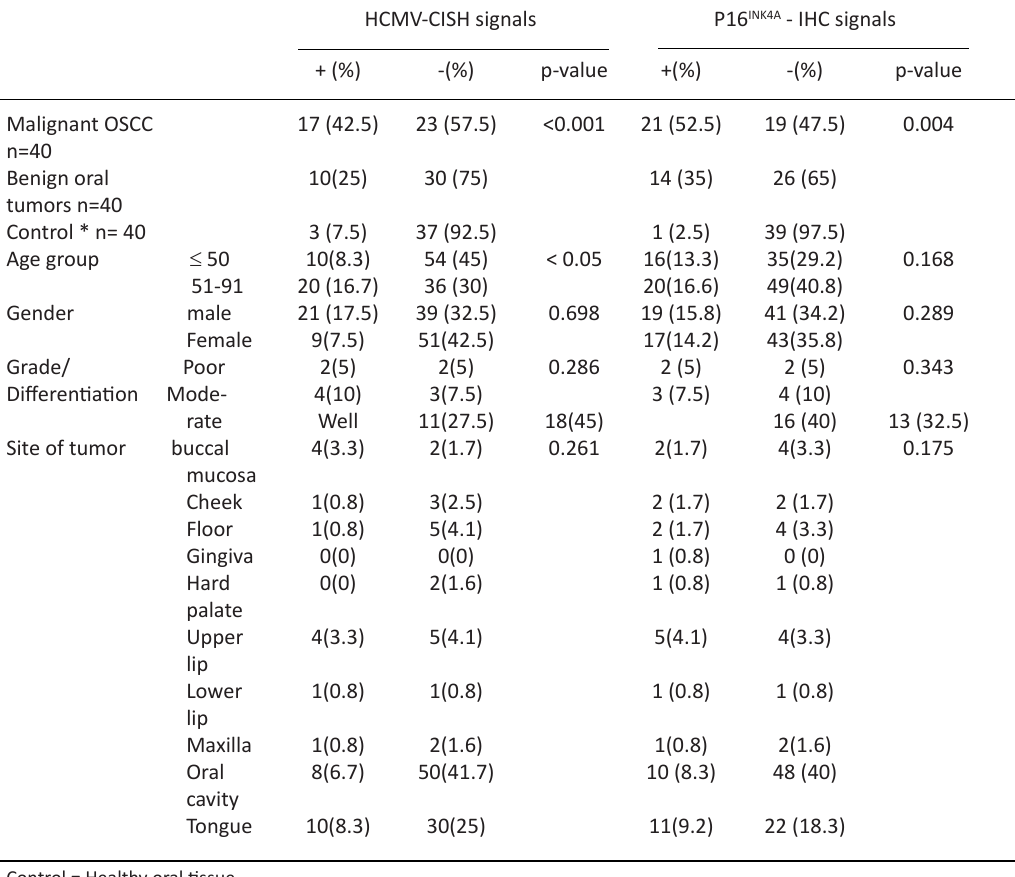
Table 2. The Results Of HCMV-DNA-CISH and P16 INK4A -IHC Among The Study Groups HCMV-CISH